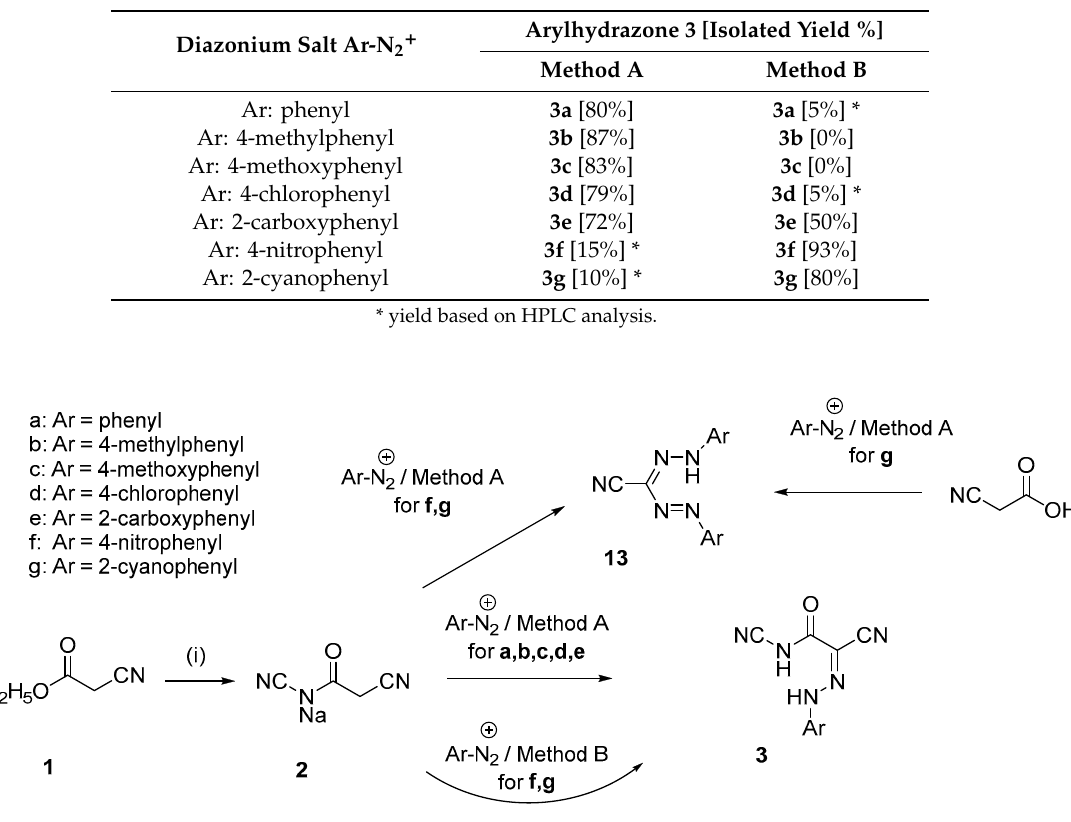
Table 1. Comparison of Methods A and B for the reaction of diazonium salts with compound 2 .